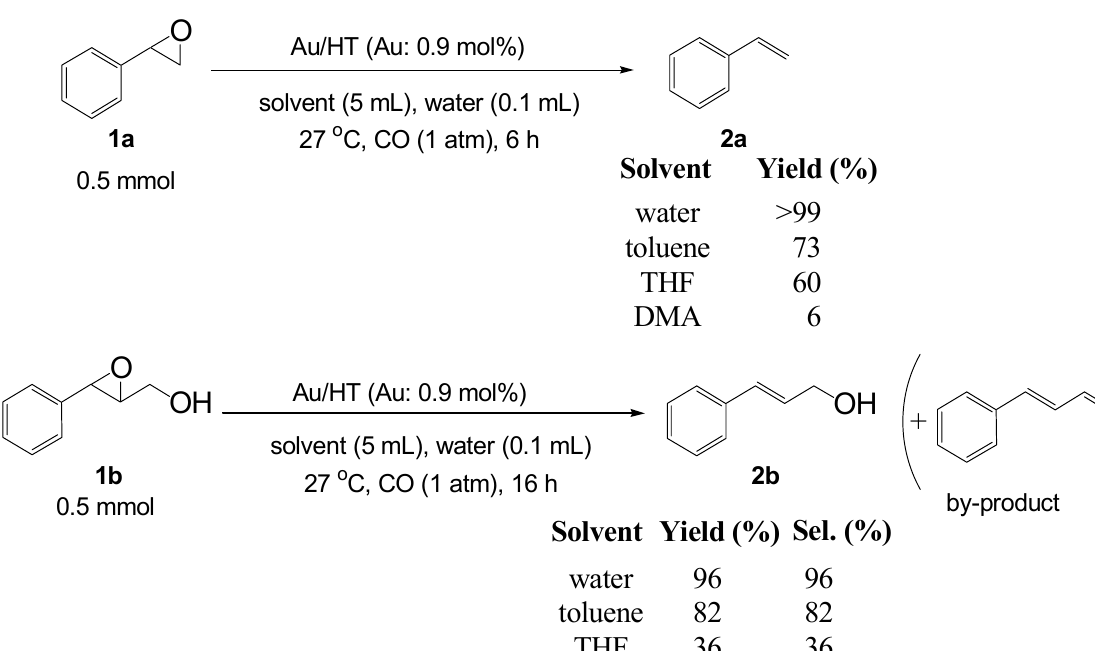
O using Au/HT a . 2 R 1